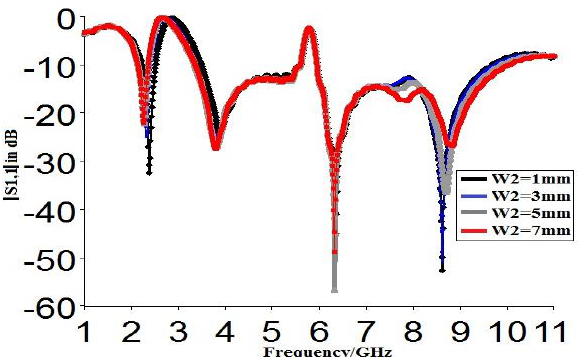
Figure 6: Simulated reflection coefficient for different L 2